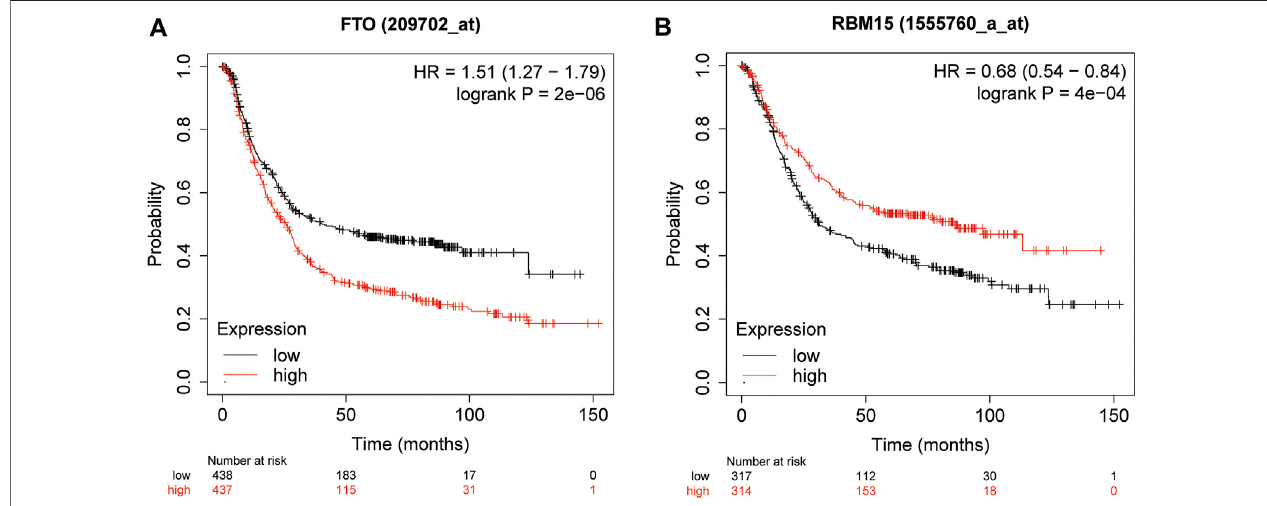
FIGURE 3 | Kaplan – Meier overall survival curves for GC patients using the online Kaplan – Meier plotter survival analysis (http://www.kmplot.com) based on the median expression of FTO (A) and RBM15 (B) . GC, gastric cancer.